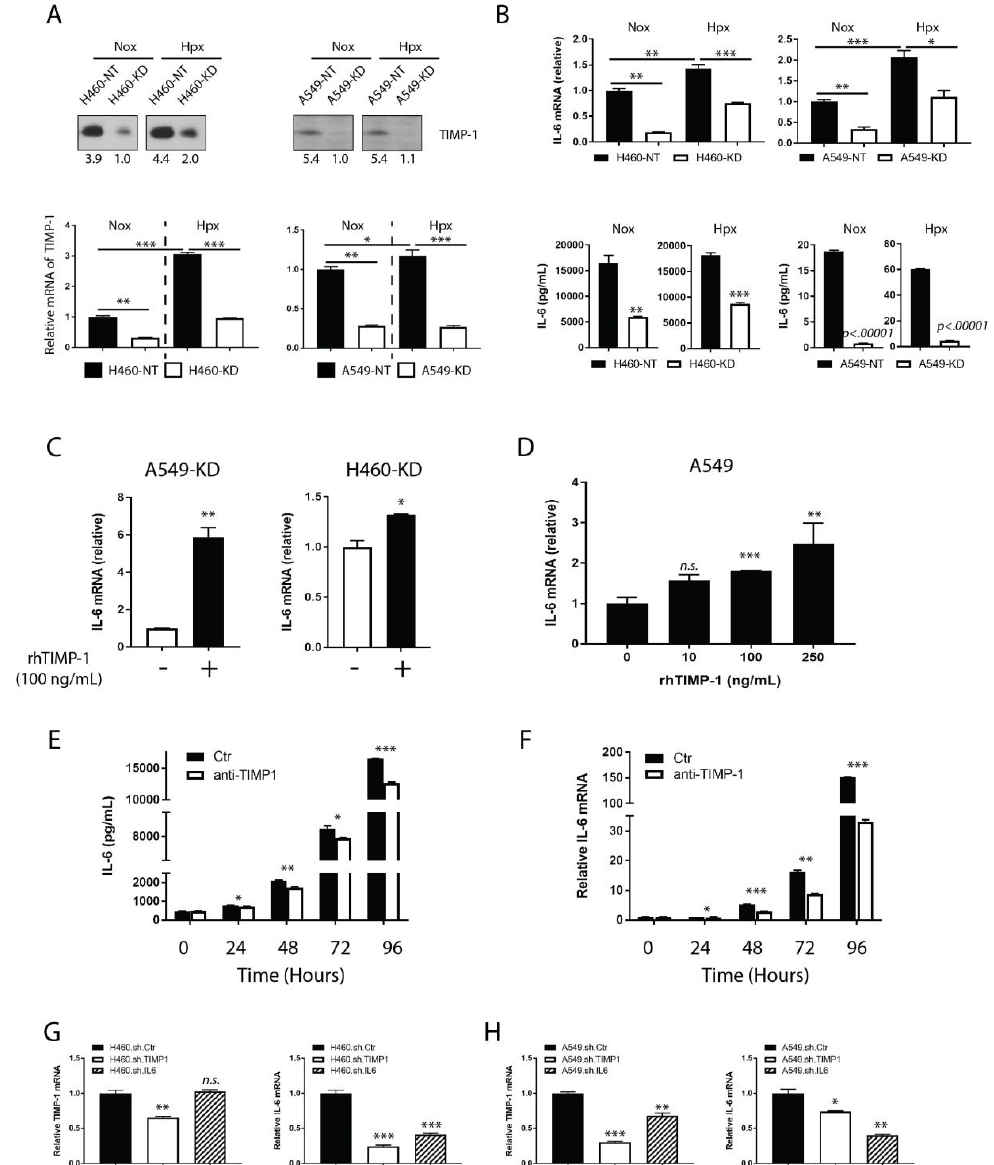
Figure 3. TIMP-1 regulates IL-6 expression. A. H460- or A549-derived TIMP-1 NT and KD clones were cultured under normoxic (20% O 2 ) or hypoxic (1% O 2 ) conditions, respectively, at 72 h. ( A ) The presence of TIMP-1 protein (upper panel) in culture supernatants was detected by immunoblot analysis. TIMP-1 mRNA transcripts (lower panel) were measured by RT-PCR. ( B ) IL-6 mRNA transcripts (upper panel) were measured in H460- or A549-derived clones under the same culture conditions as above, by RT-PCR. IL-6 protein levels (lower panel) in supernatants from the above cell cultures were titrated by ELISA. ( C ) A549-KD, or H460-TIMP-1 KD clones were treated with exogenous rhTIMP-1 (100 ng / mL) for 24 h. IL-6 mRNA transcripts were measured by RT-PCR. ( D ) A549 cells were treated with exogenous rhTIMP-1 at di ff erent doses (ranged from 0 ng / mL to 250 ng / mL) for 24 h. Cell lysates were used to measure IL-6 mRNA transcripts by RT-PCR. ( E , F ) H460 cells were cultured in complete media for four days. In parallel, one group of cells was treated with neutralizing anti-TIMP-1 antibodies (500 ng / mL), while another group was treated with goat IgG as a control. Culture medium supernatants were collected in pairs at 0, 24, 48, 72, and 96 h, respectively. The IL-6 protein was also titrated by ELISA. The IL-6 mRNA level was determined in cell pellets in the above conditions by RT-PCR. Cell attachment time was defined as the 0 h time-point. ( G , H ) To determine the bona fide relationship between TIMP-1 and IL-6, TIMP-1 KD, IL-6 KD, and NT clones were constructed with